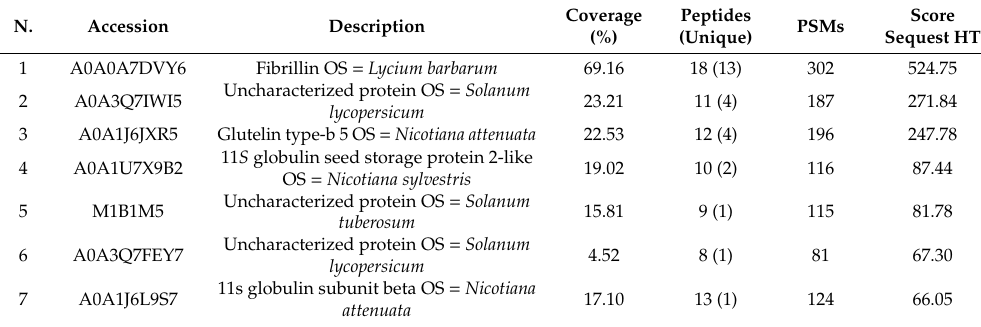
Table 2. Protein identification in protein extract of GB (goji berry) by bottom-up proteomics by filtering hits to the first 30 proteins identified at the highest